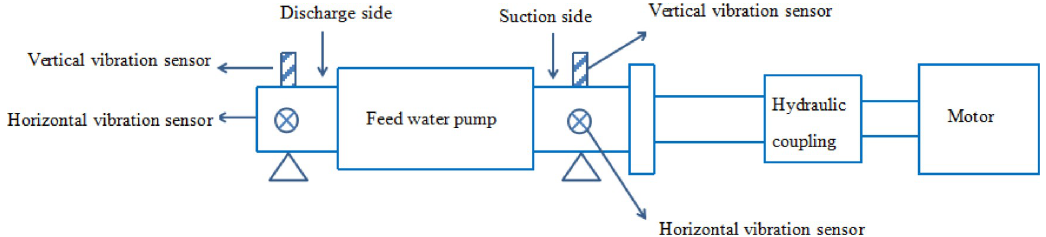
Fig 5. Schematic diagram of data collection system for electrically driven feed pump.